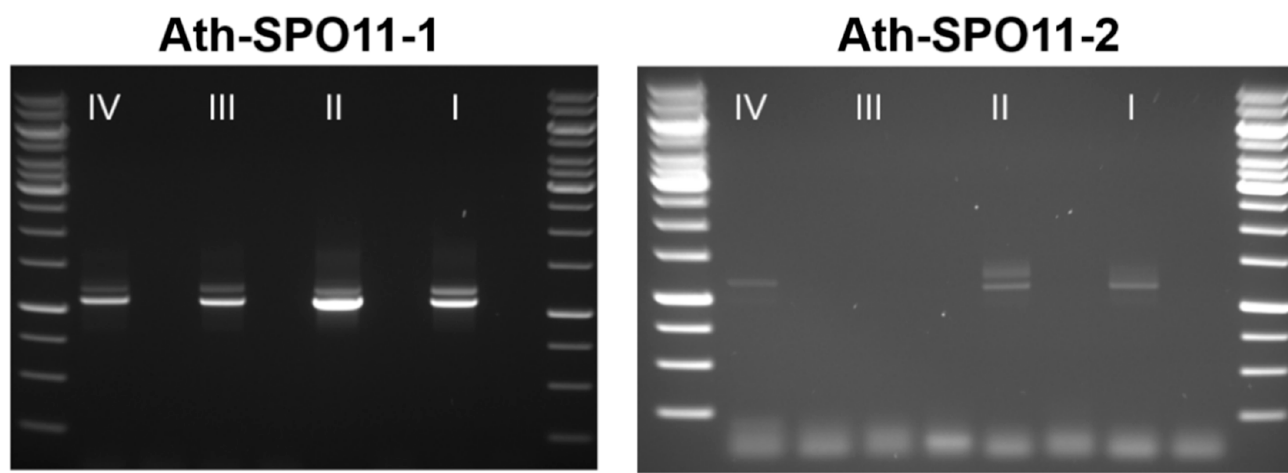
Figure 11. Semiquantitative RT-PCR of SPO11-1 and -2 from Arabidopsis thaliana . Different Anthere stages (I–IV) have been evaluated for alternative splicing using a semiquantitative RT-PCR using the same amount of RNA. In most samples, the alternative or aberrant splicing products are visible as an additional band in the gel.